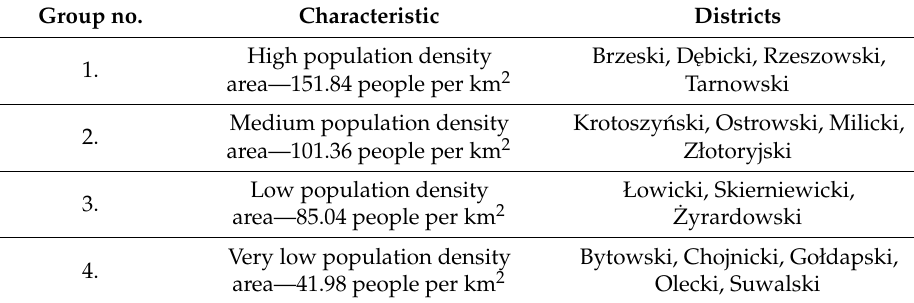
Figure 1. Location of research areas (source: own elaboration based on GGOD data). Table 1. Characteristics of district